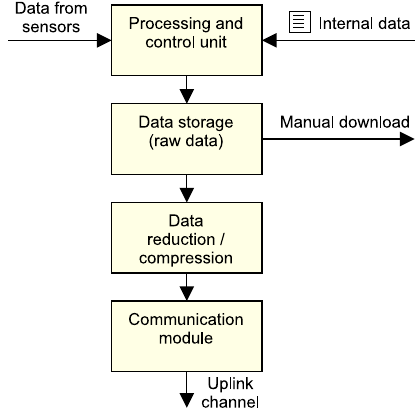
Figure 8. Data handling in an uplink data channel.